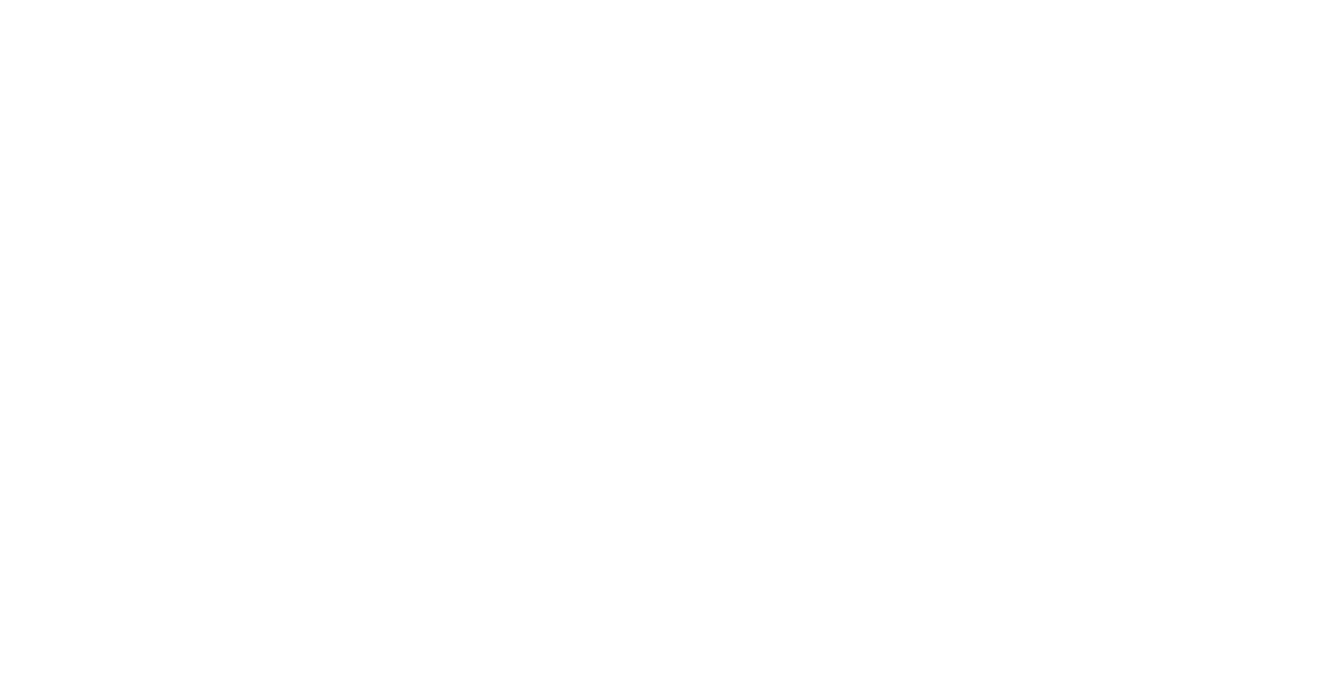
Frontiers in Chemistry | www.frontiersin.org